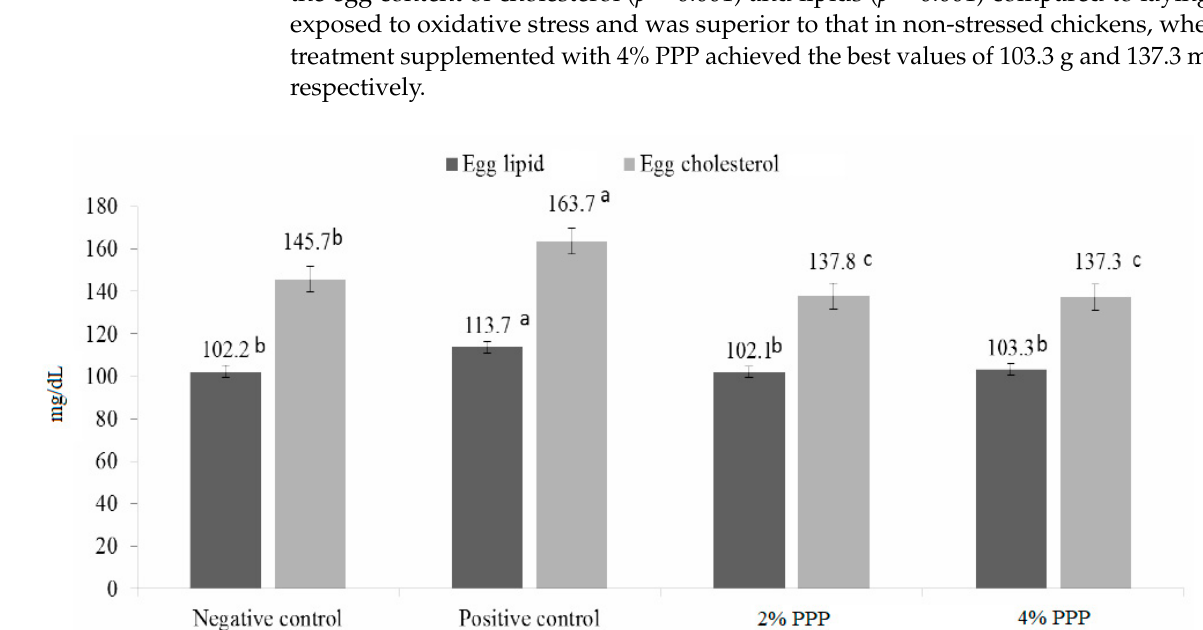
Figure 1. Effect of different levels of dietary pomegranate peel on egg yolk lipid content ( p < 0.001) and cholesterols ( p < 0.001) of laying hens subjected to oxidative stress. Bars sharing a common superscript are not statistically different. DEX, dexamethasone; PPP, pomegranate peel powder ( n = 10 birds for each treatment). a–c Bars with different superscript are significantly different ( p ≤ 0.05).